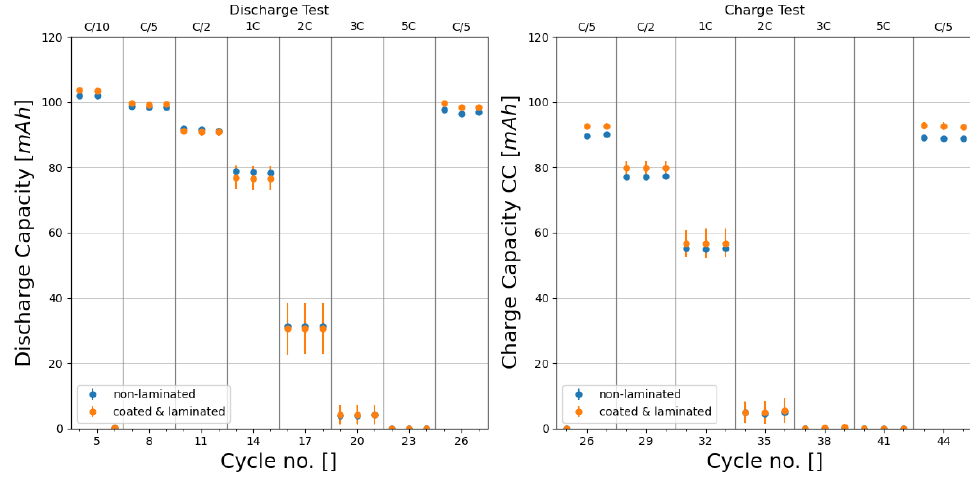
Figure 5. Results of C-rate tests on cells with ceramic separator. Discharge rate ( left ) or charge rate ( right ) increased stepwise from C/10 to 5 C with the respective other half cycle being per- formed at C/5. ESLs laminated at 160 °C and with a line force of 10 N/mm; test performed after formation. The discharge capacity in the sixth cycle is an measurement artifact due to an internal resistance measurement.